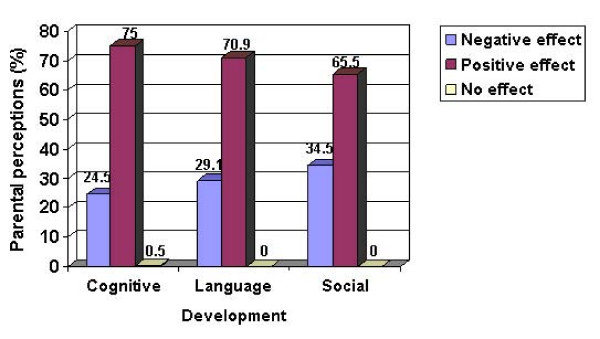
Parental perceptions on the effects of television viewing toward children's development. 75, 70.9 and 65.5% of parents believed that television viewing had positive effect to children's cognitive, language and social development.